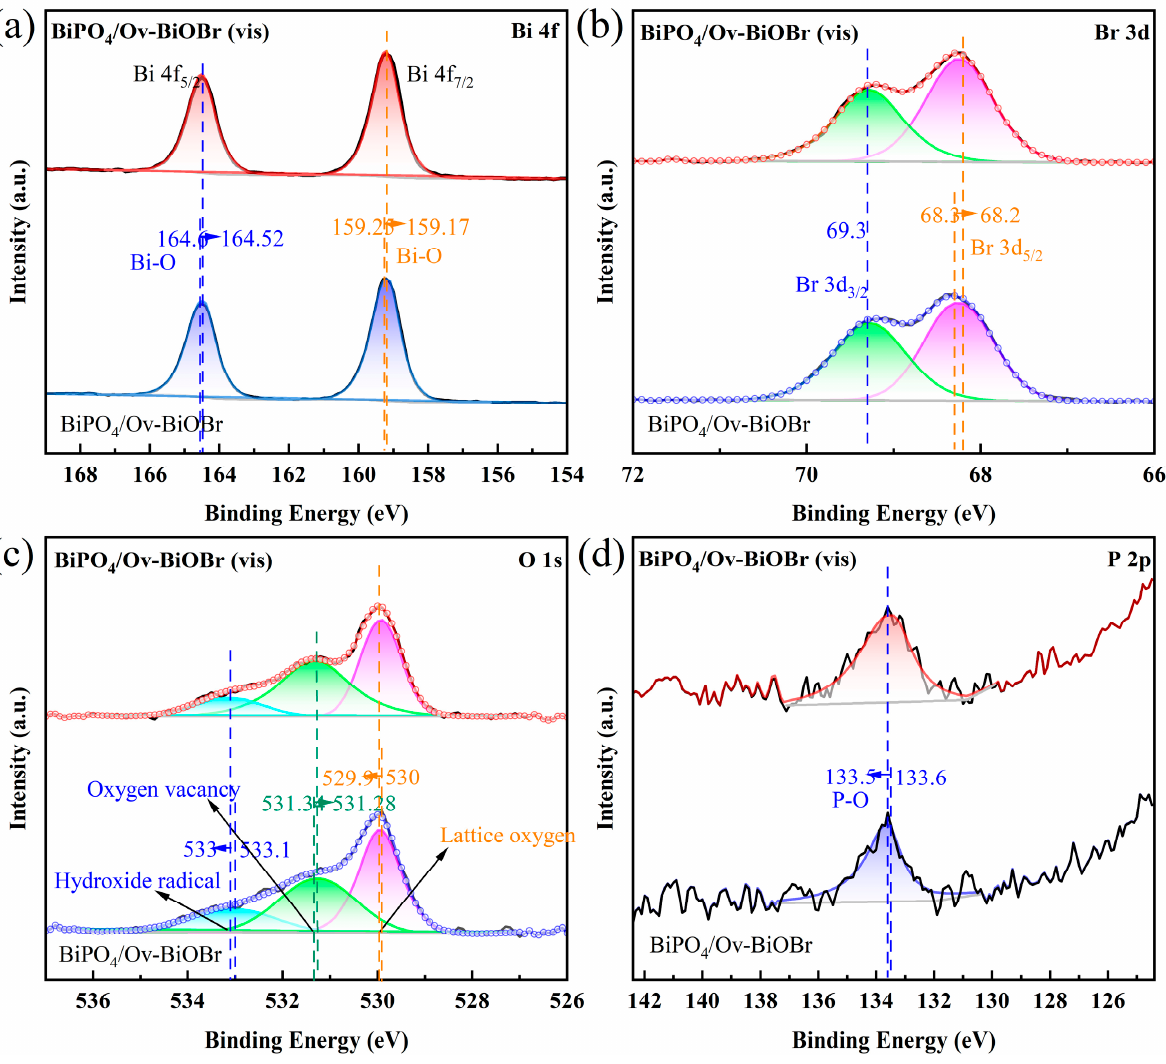
Figure 3. In situ irradiation XPS spectra of BiPO 4 /Ov-BiOBr ( a ); high-resolution XPS maps of Bi 4f ( b ), Br 3d ( c ), O 1s ( d ) and P 2p ( e ).